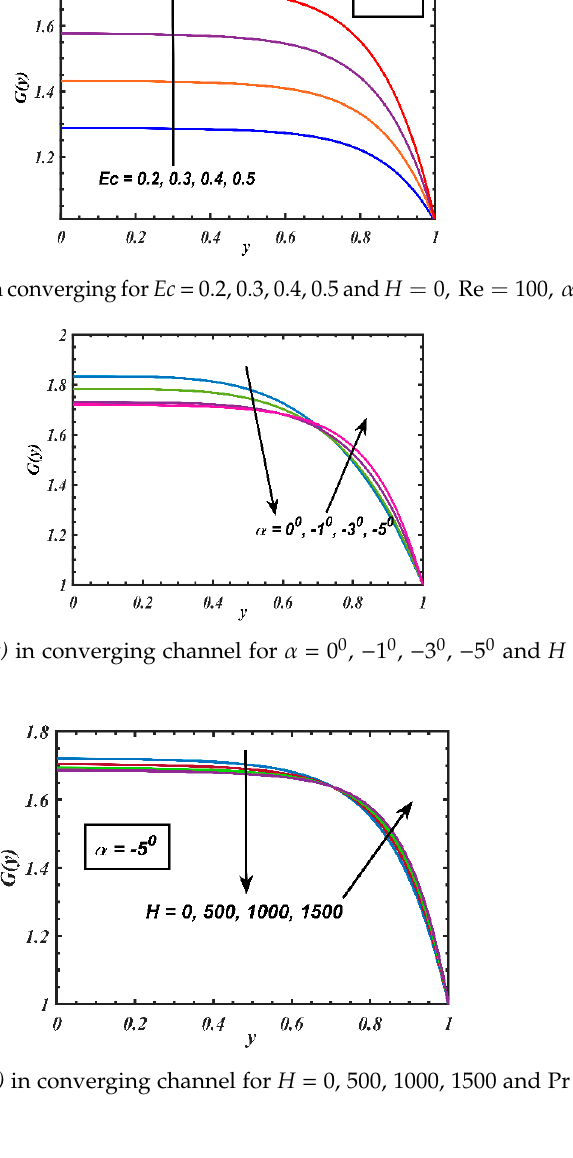
Figure 8. Variation of G(y) in converging channel for Pr = 1, 2, 3, 4 and H = 0, Re = 100, α = − 5 0 , Ec = 0.5.